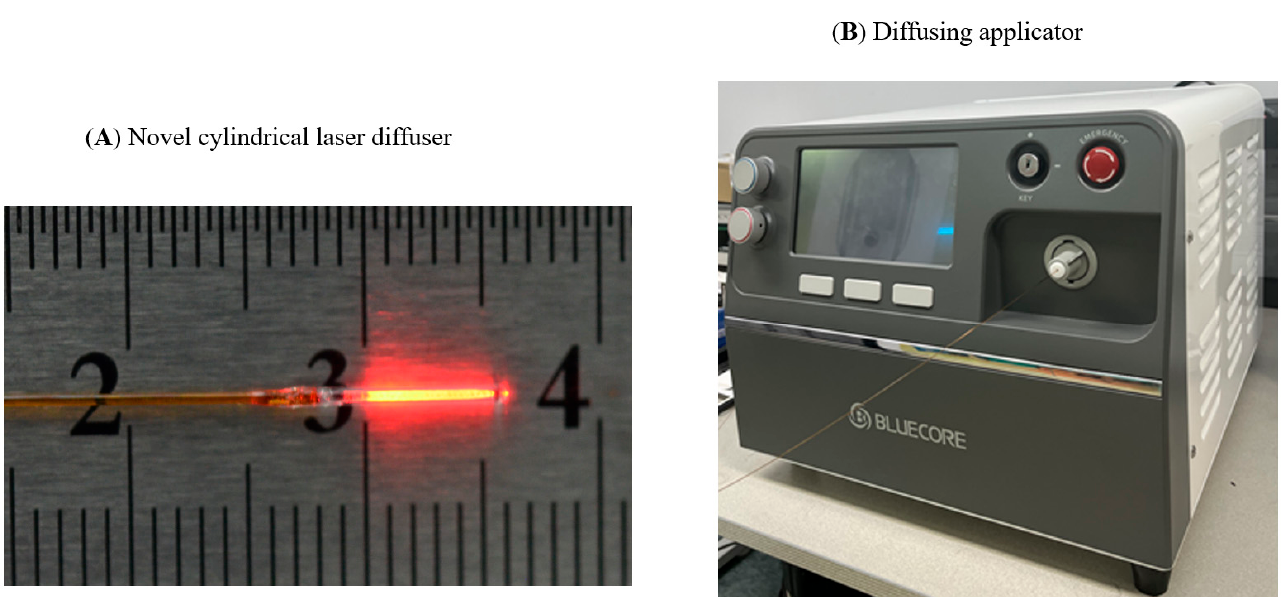
Figure 1. Laser ablation device.